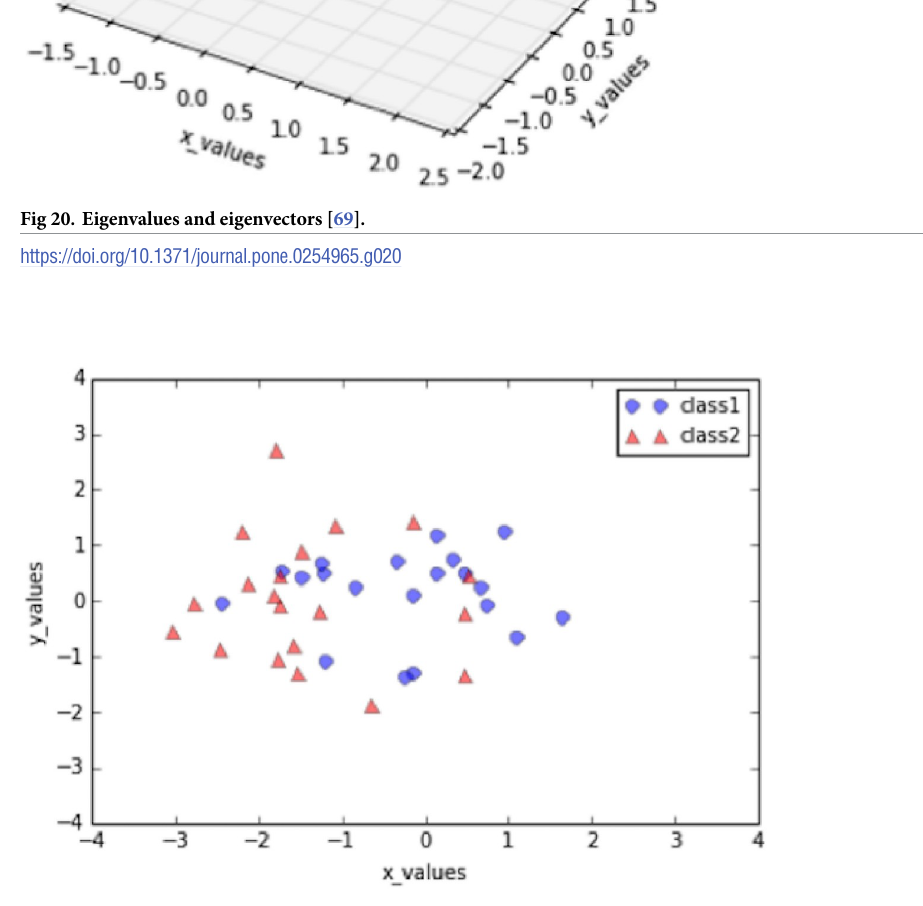
Fig 21. Classification by using standard PCA [69].